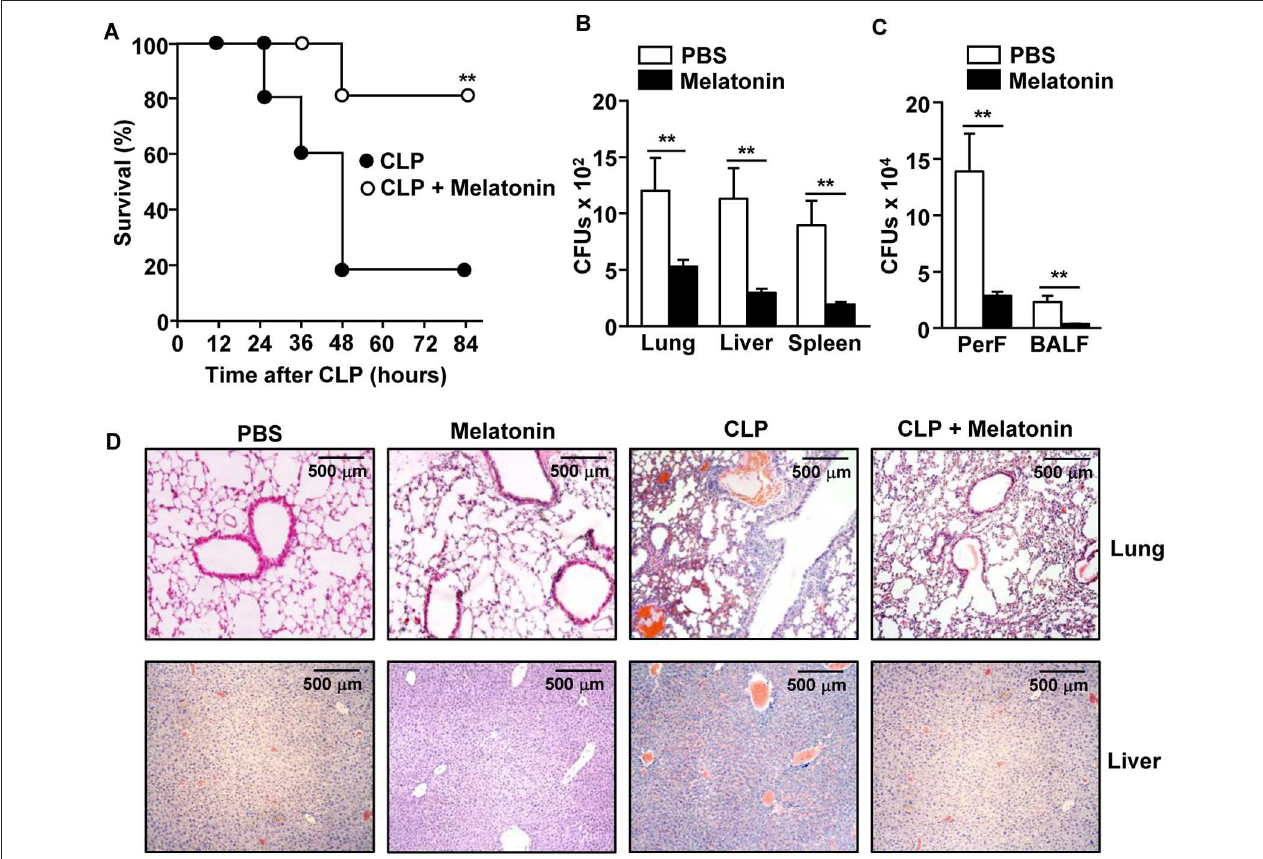
FIGURE 1 | Melatonin attenuated the CLP-induced mortality in mice. C57BL/6 mice were injected with 50 mg/kg melatonin for 30min before they underwent CLP surgery. Thirty minutes after the surgery, the mice received the same concentration of melatonin again. (A) The survival rate of the mice was monitored. ** p < 0.01, based on ANOVA. Sample size, n = 10 per group. (B) Bacterial colony forming units (CFUs) were measured for homogenates of the lung, liver, and spleen, 24h after the CLP surgery. (C) The CFUs in the peritoneal fluid (PerF) and bronchoalveolar lavage fluid (BALF). (D) Hematoxylin and eosin (H&E) staining of the lung and liver 24h after CLP surgery. Data represent the average of six independent samples (two mice per experiment, for a total of three experiments). ** p <